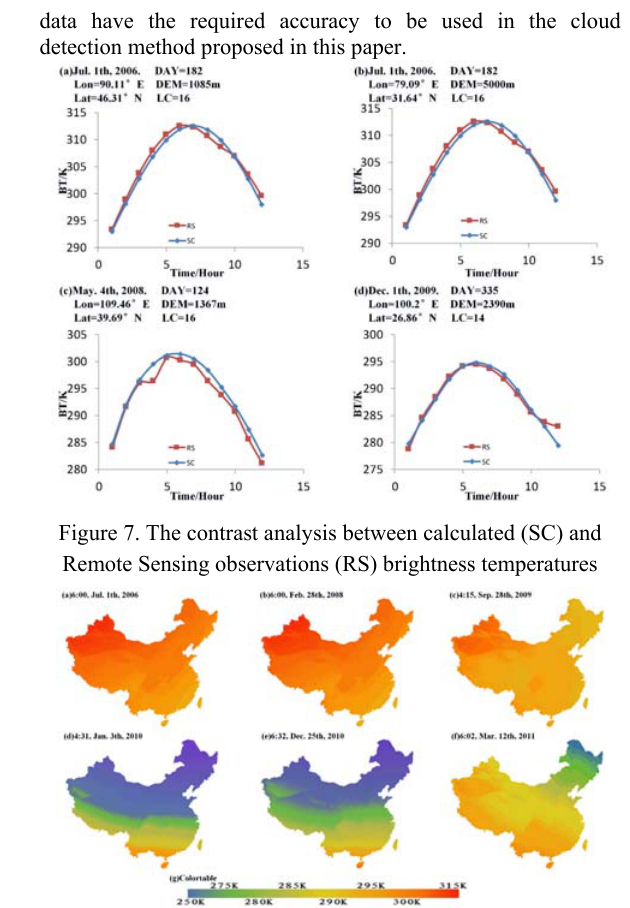
Figure 8. The calculated result of clear sky BT about the Chinese mainland